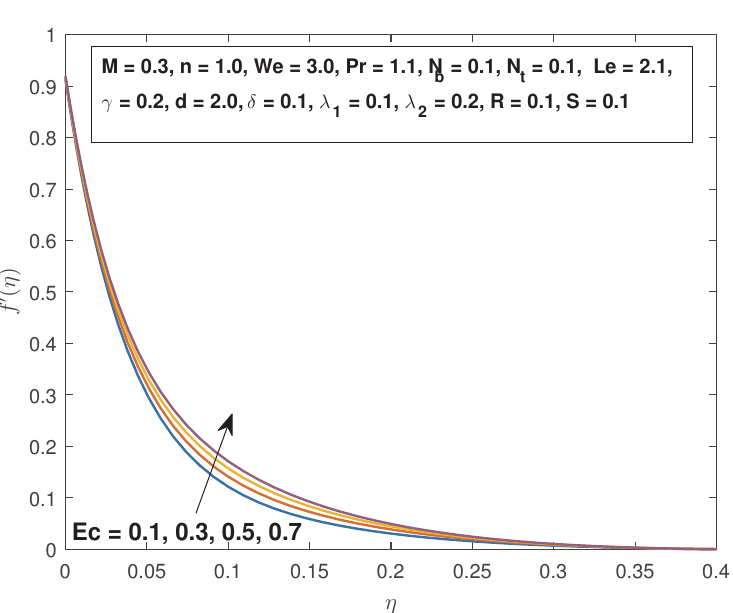
Figure 6. Effects of δ on the fluid velocity.